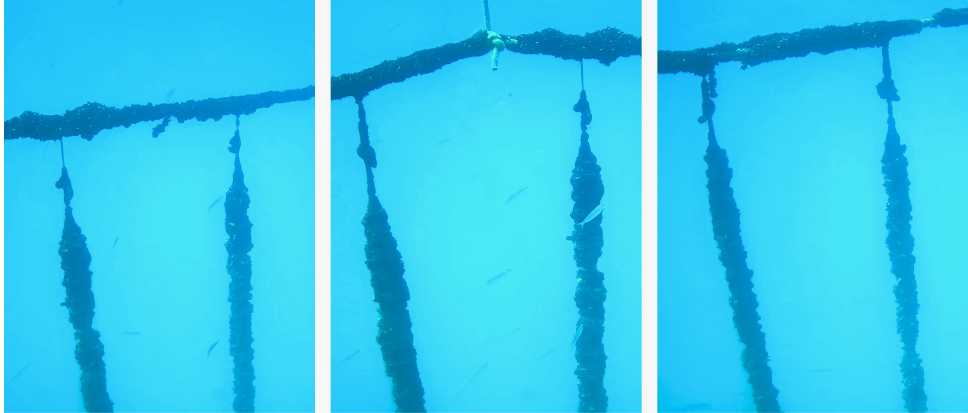
Figure 15. PilotCAM image sequence for mussel farming nets: Mitylus